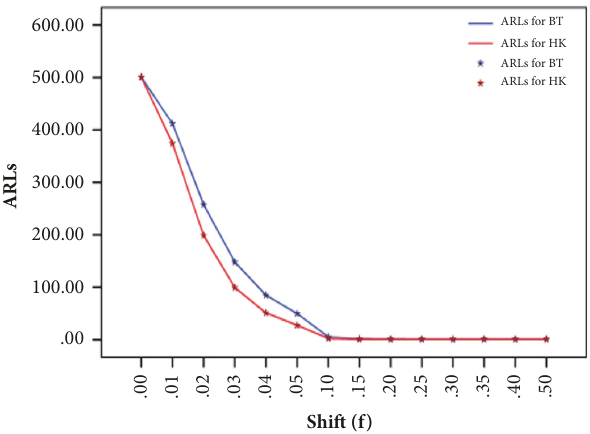
Figure 17: ARLs for proposed repetitive EWMA-RSS control charts using ratio estimators, for 𝜌 = 0.50 when 𝑟 𝑜 = 370 at 𝜆 =